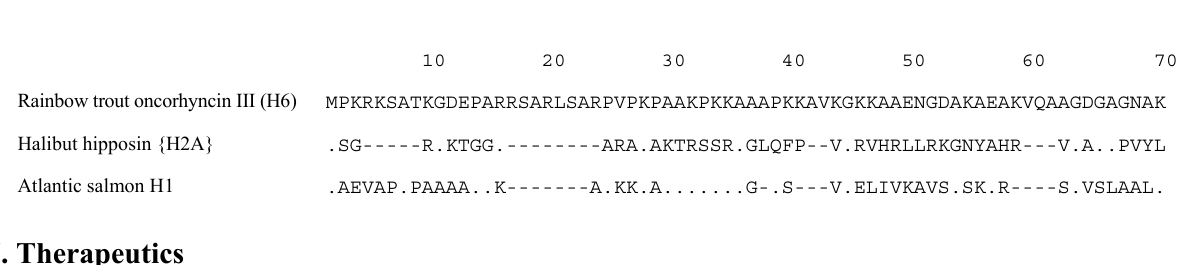
Figure 5. Alignment of histone-derived peptides. Representative peptide sequences were obtained from published data and from the PubMed protein database, and were aligned using MacVector software. Since the sequences are homolgous to different histone peptide fragments, there is no shared sequence